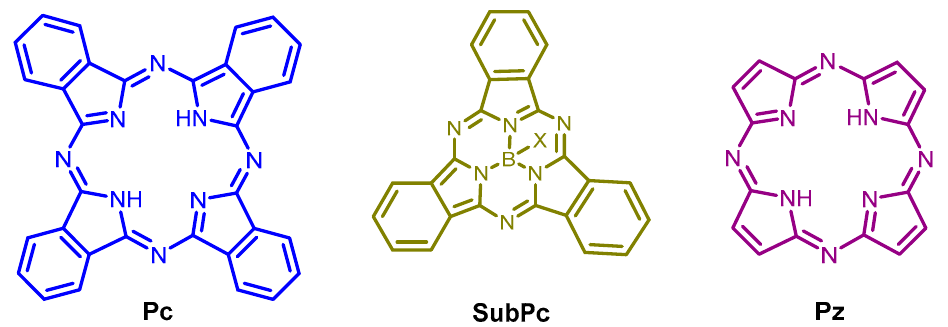
Figure 1. General structures of phthalocyanine ( Pc ), subphthalocyanine ( SubPc ) and porphyrazine ( Pz ).